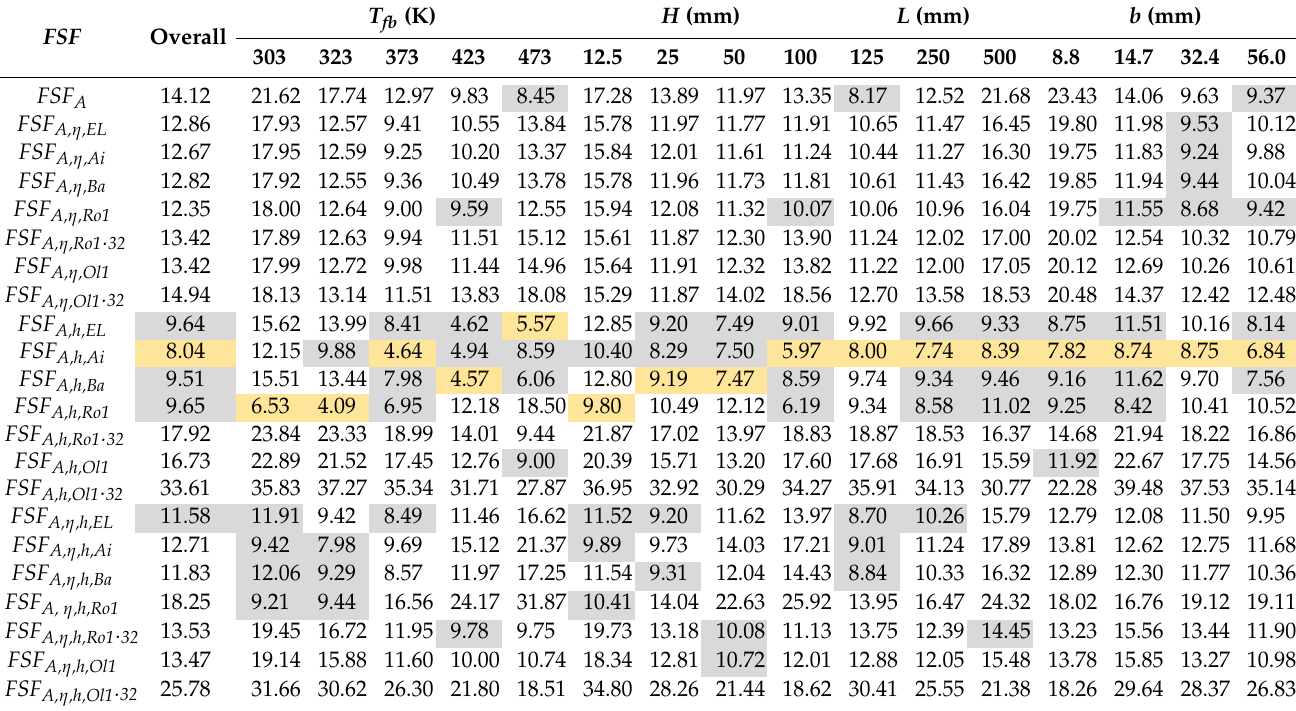
Table 4. The relative deviation according to the amount of the heat flows results from the different FSF s concerning the respective reference heat flows FSF ref,i . The smallest deviations are